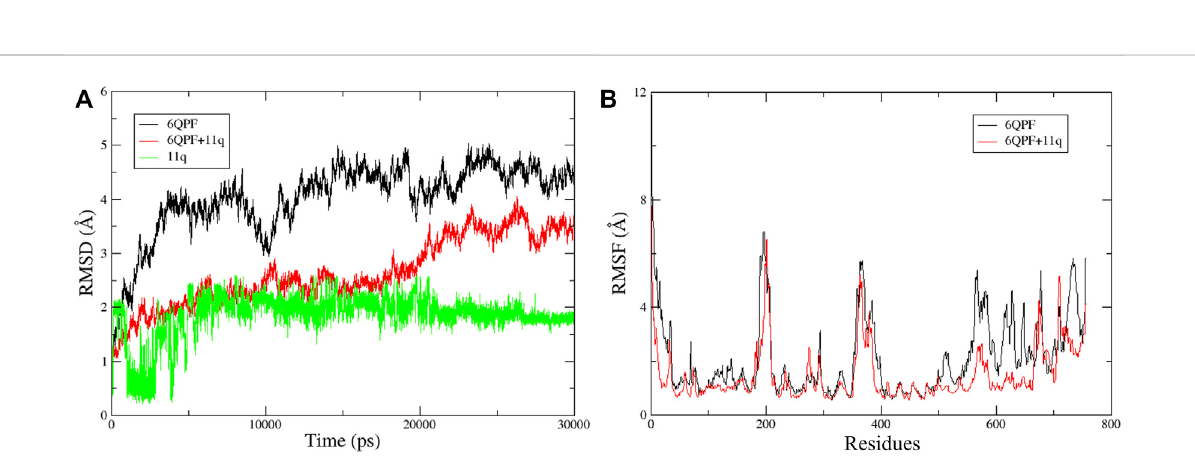
FIGURE 8 Trajectory analysis results obtained for 30 ns MD simulations: (A) The RMSD plots of the apoprotein (6QPF), protein complex (6QPF + 11q ) and docked ligand ( 11q ); (B) RMSF plots of the apoprotein (6QPF) and protein complex (6QPF + 11q